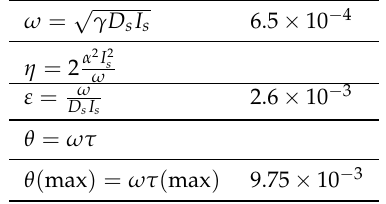
Table A2. Dimensionless parameters and their